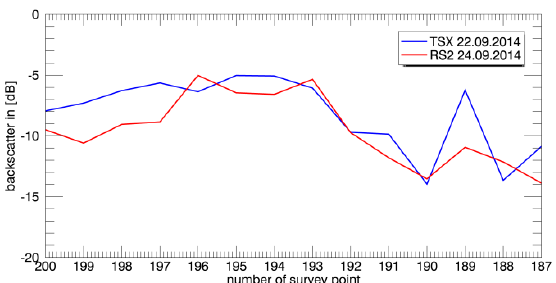
Figure 6. Profile near Hinterer Brochkogel (green points in Figure 4) with the backscatter values of TSX image in blue and the backscatter values of RS2 image in red. Survey point 200 is located at 2995 m altitude, point 187 at 3265